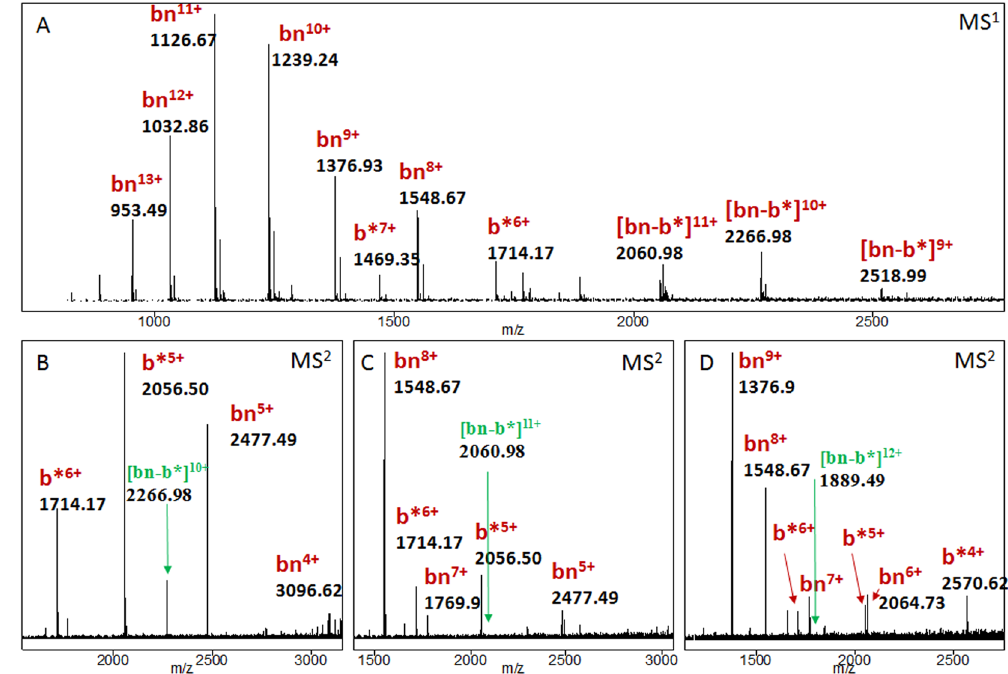
Figure 1. Ionization and fragmentation of the bn-b * complex. ( A ) - The broadband mass spectrum. ( B ) – Fragmentation of [bn-b * ] 10 + , ( C ) –fragmentation of [bn-b * ] 11 + , ( D ) –fragmentation of [bn-b * ] 12 + . The precursor ions are given in green. For the full range spectrum see Figure